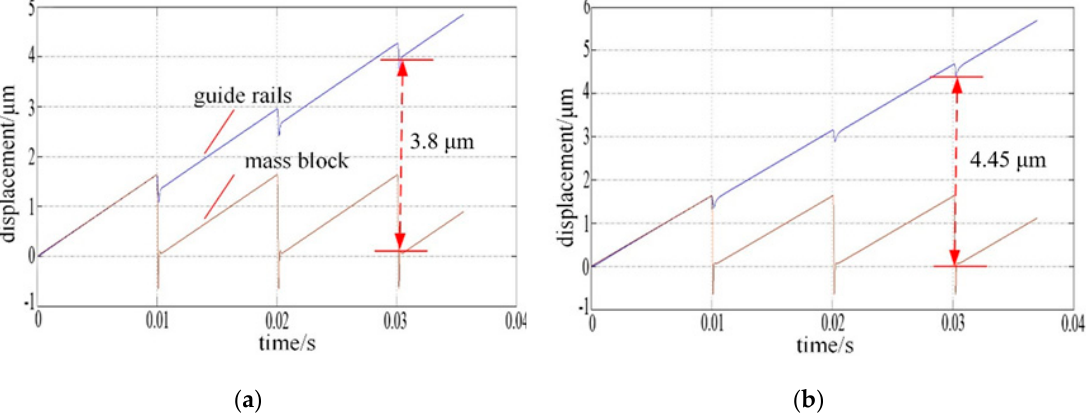
Figure 9. Simulation results of displacement under different working load: ( a ) 0.032 kg; ( b ) 0.064 kg.